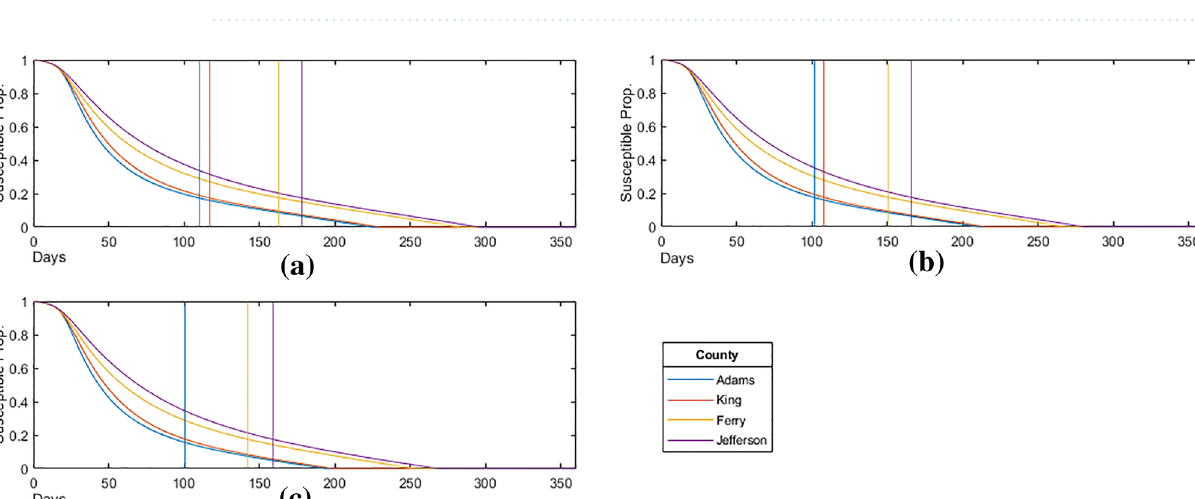
Figure 18. Susceptible proportion for: ( a ) the homogeneous priority distribution ( ω = ω C ); ( b ) the moderate priority distribution ( ω = ω M ); ( c ) the strict priority distribution ( ω = ω S